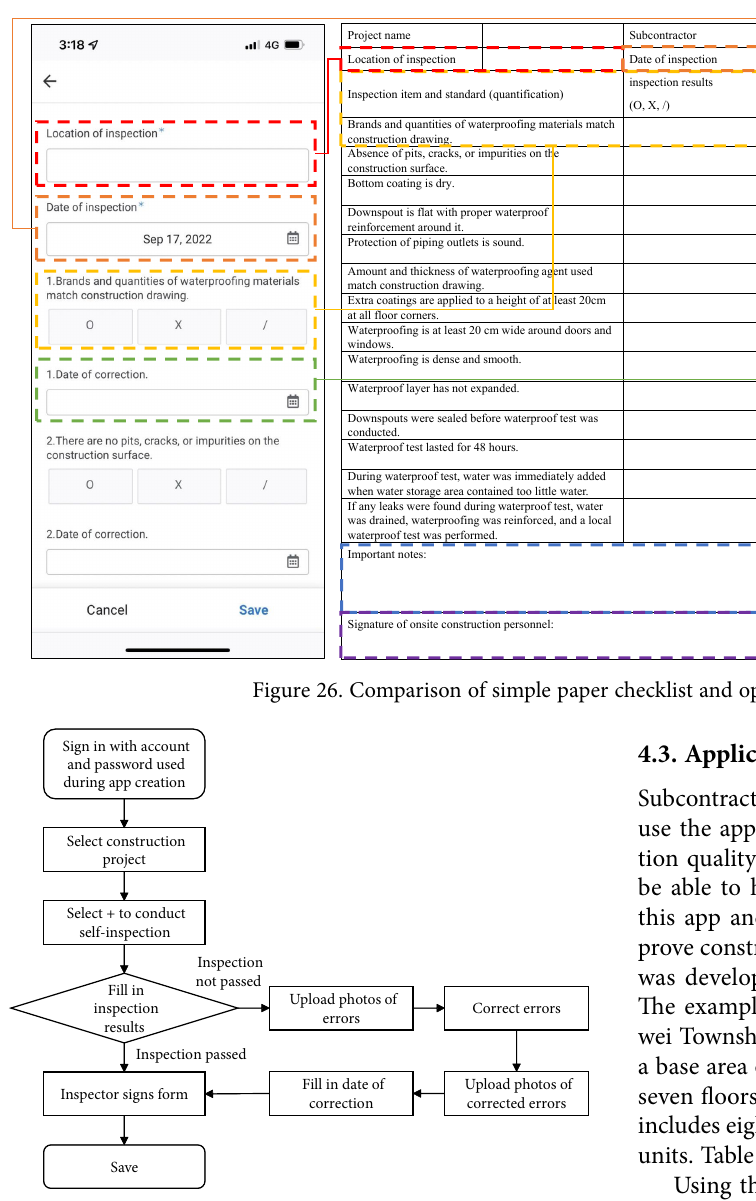
Figure 27. Flow chart of inspection app operations